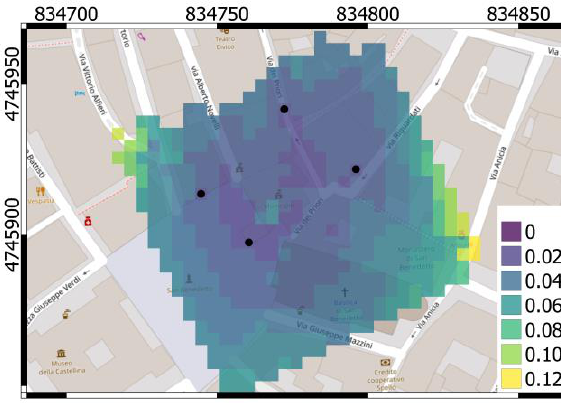
Figure 5. Estimated precisions [m] along X axis.